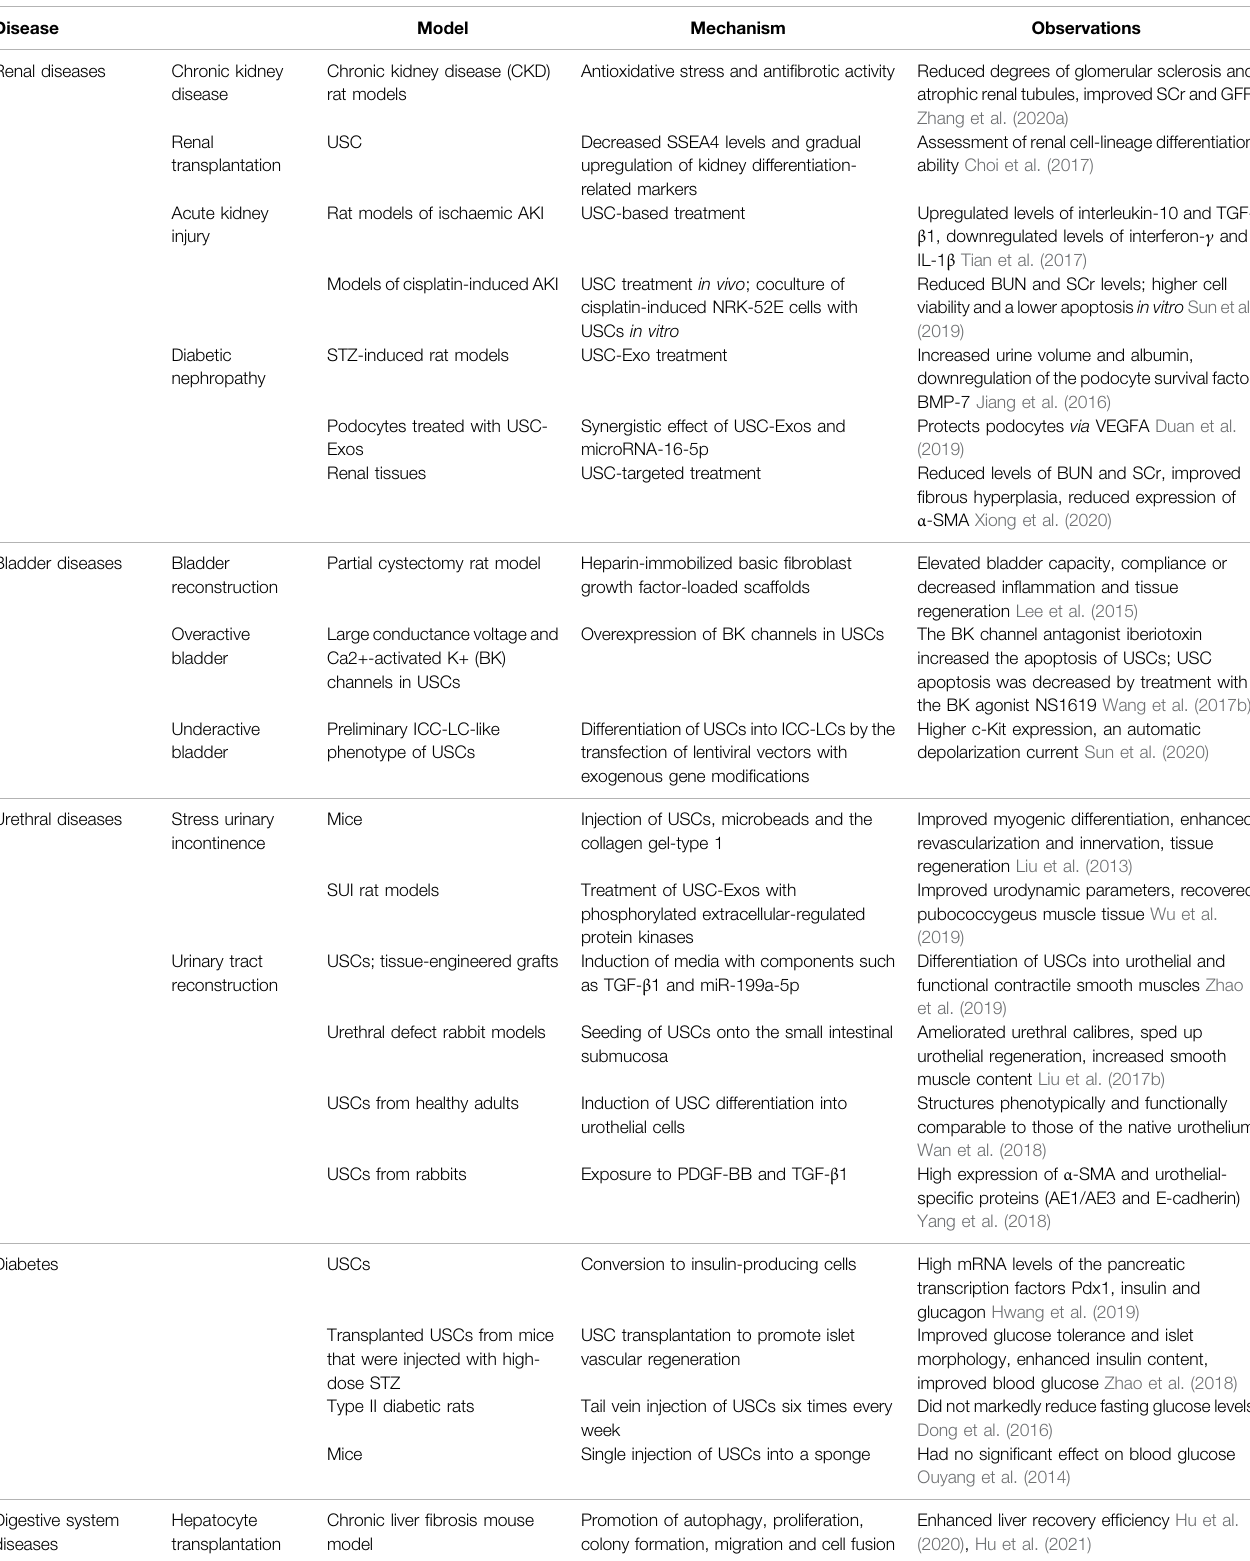
TABLE 1 | USC-based therapies for various diseases of bodily systems.